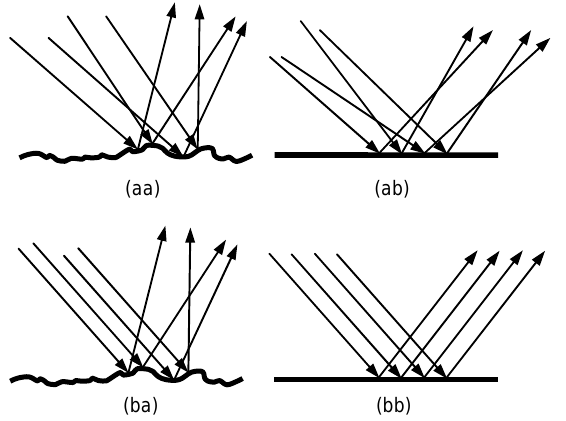
Figure 4: Diffuse illumination: diffuse (aa) vs. specular reflection (ab). Directional lighting: diffuse (ba) vs. specular reflection (bb).